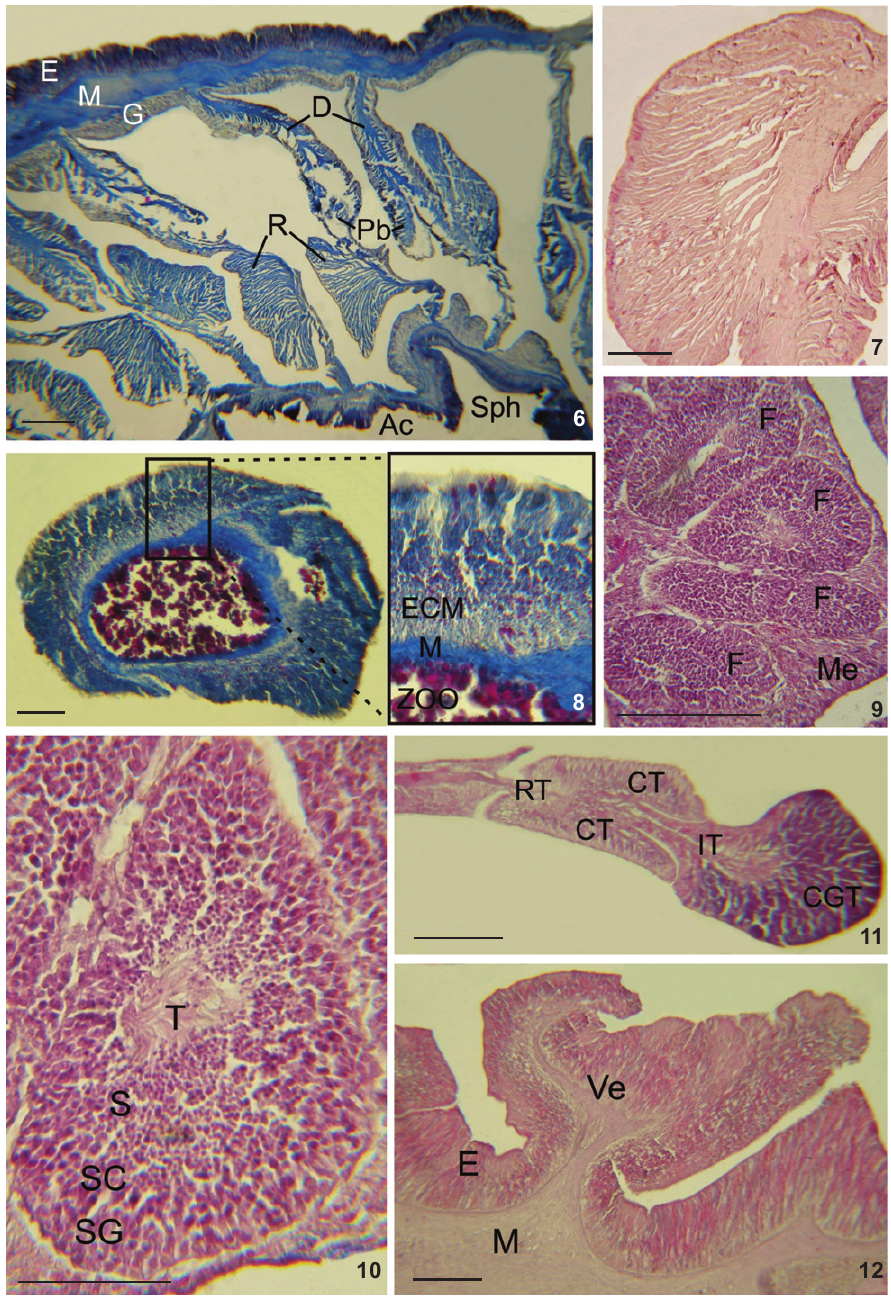
Figures 6-12. Bunodactis octoradiata internal anatomy: (6) cross section through the column proximal to the actinopharynx (Ac) (D: directive mesenteries, E: ectoderm, G: gastrodermis, M: mesoglea, Pb: parietobasilar muscles, R: retractor muscles, Sph: